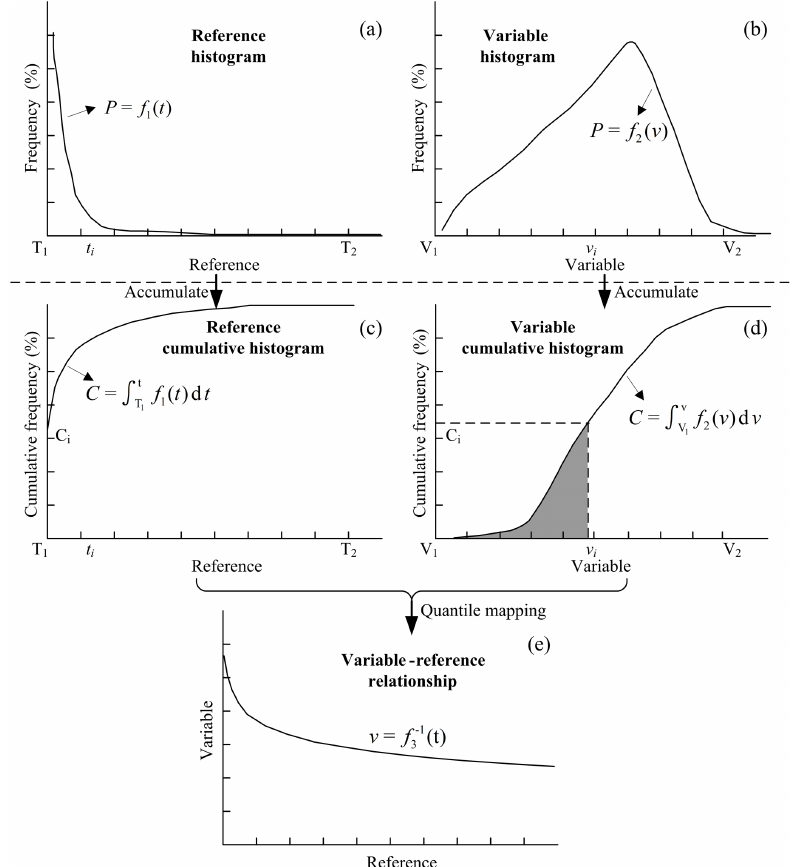
Figure 2. Schematic of the cumulative distribution of frequency (CDF) matching